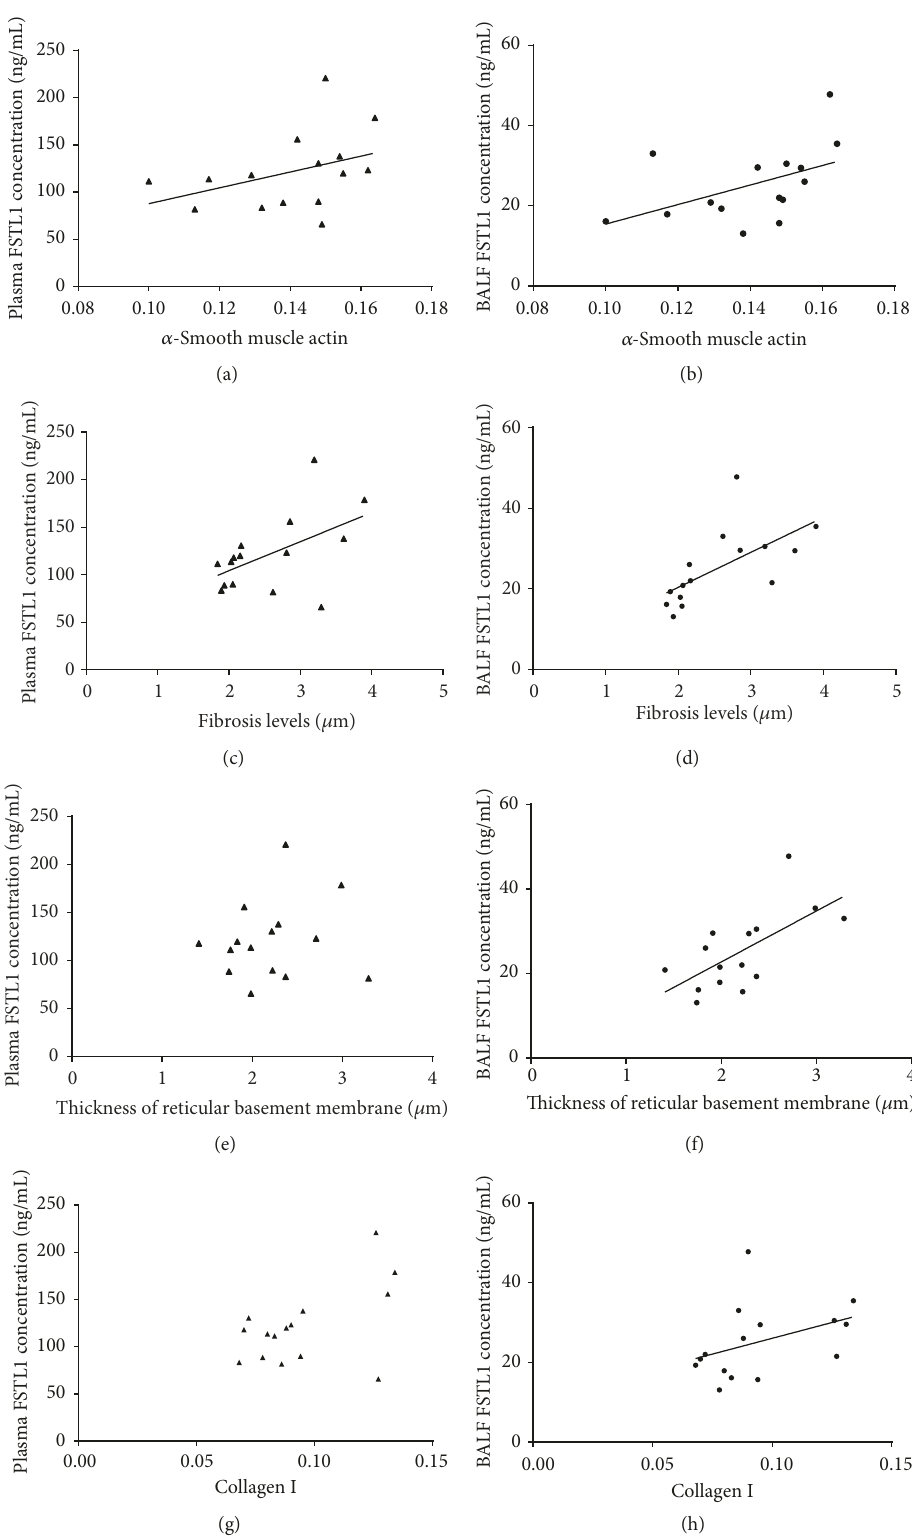
Figure 5: Relationships between FSTL1 levels in plasma and BALF and airway remodeling. Correlation between α -smooth muscle actin and (a) plasma FSTL1 concentration and (b) BALF FSTL1 concentration. Correlation between fi brosis levels and (c) plasma FSTL1 concentration and (d) BALF FSTL1 concentration. Correlation between basement membrane thickness and (e) plasma FSTL1 concentration and (f) BALF FSTL1 concentration. Correlation between collagen I levels and (a) plasma FSTL1 concentration and (b) BALF FSTL1 concentration. Correlation was determined by Spearman rank correlation